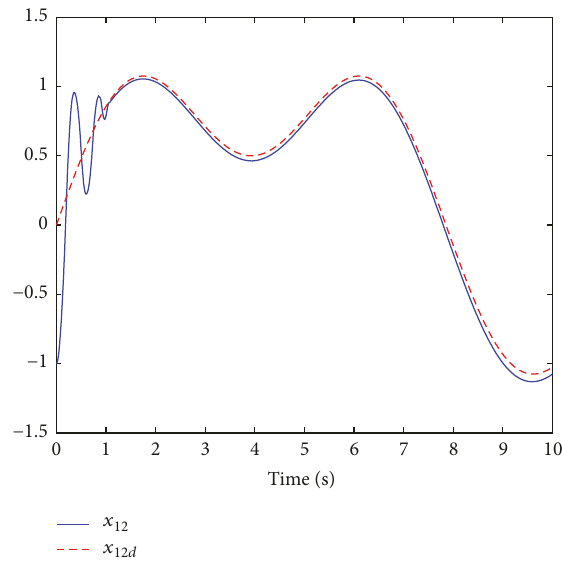
Figure 2: Tracking result of 𝑥 12 in response to 𝑥 12𝑑